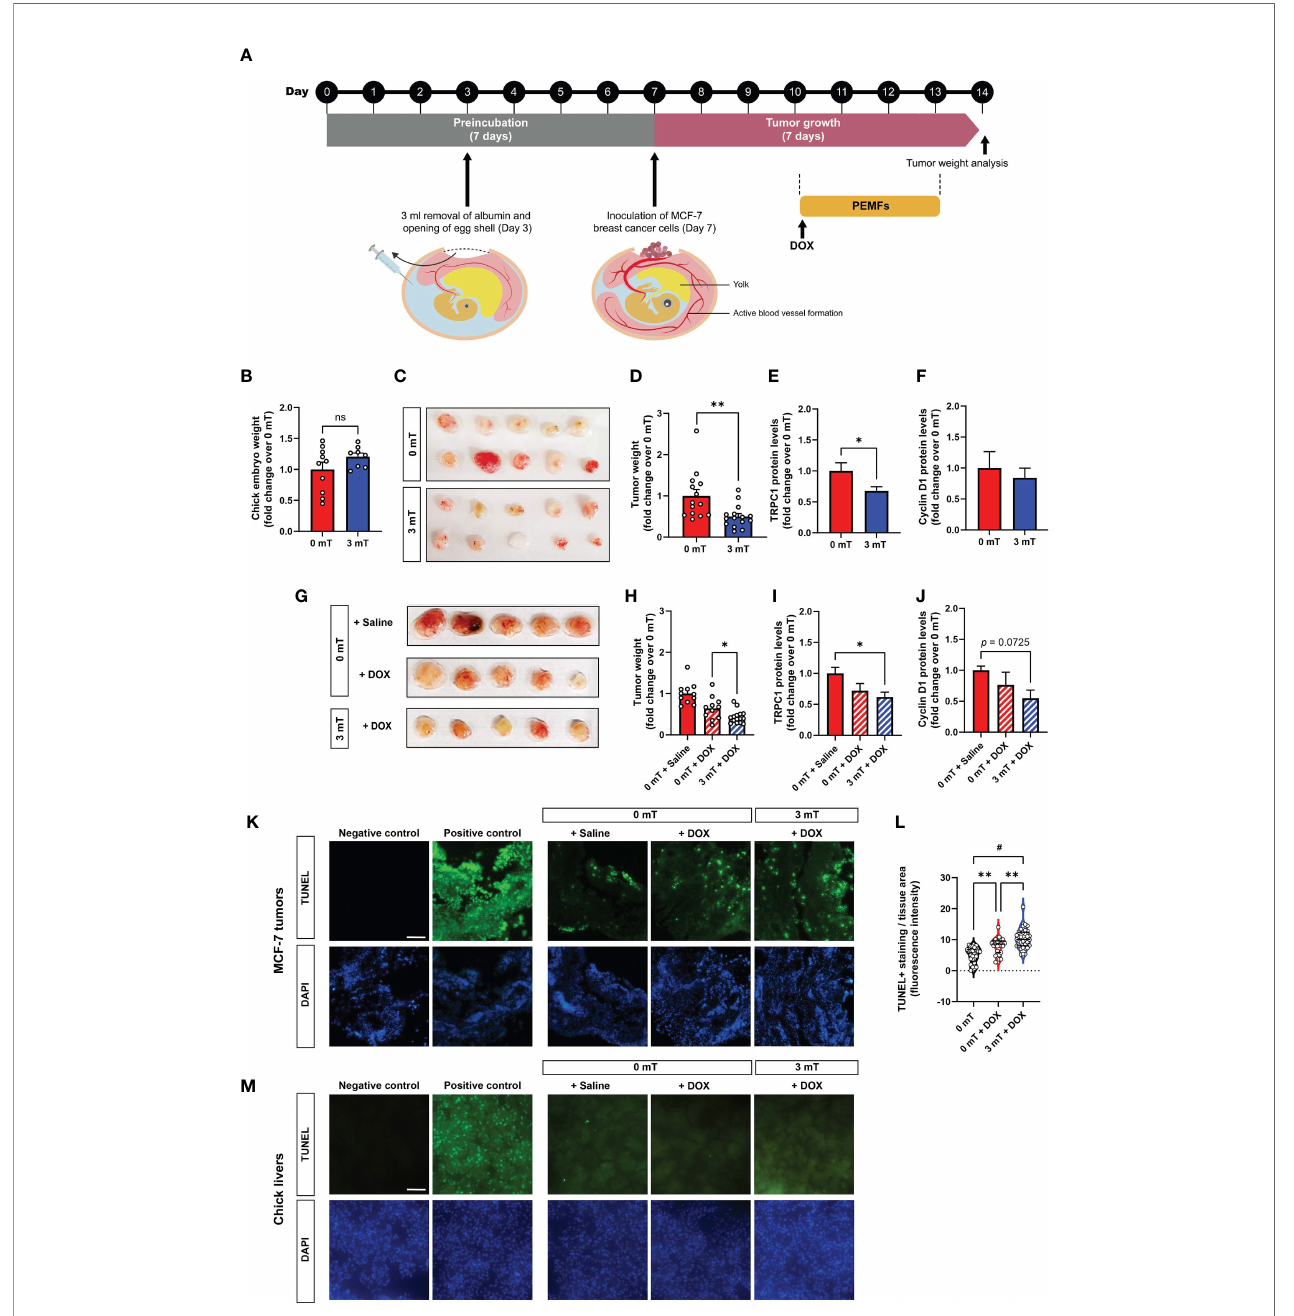
FIGURE 2 | PEMF inhibits breast tumor growth in vivo correlated with depressed TRPC1 expression levels. (A) Schematic of the PEMF exposure paradigm used on the CAM model for MCF-7 breast tumor xenografts. MCF-7 tumors were inoculated onto the CAM on day 7. The tumors were either exposed to 3 mT for 1 h for 4 successive days or exposed to 3 mT after 1 h of DOX treatment (0.04 ug/g) from day 10 onwards. (B) Chick embryo weight at study termination on day 14 for both groups. (C) Representative images of MCF-7 tumor size at day 14 and corresponding quanti fi cation (D) represented as fold change over 0 mT. TRPC1 (E) and Cyclin D1 (F) expression levels normalized to GAPDH, respectively, expressed as fold change over 0 mT. (G) Representative images showing MCF-7 tumor size after treatment with the indicated conditions. Pooled data of tumor weight (H) expressed as fold change over 0 mT. TRPC1 (I) and Cyclin D1 (J) protein expression levels normalized to GAPDH and expressed as fold change over 0 mT. Measurements were minimally in triplicates, from minimally 6 independent eggs; * p < 0.05 and **p < 0.01 or as indicated. Error bars represent the standard error of the mean. (K) Representative TUNEL staining of isolated MCF-7 CAM tumors (n=4 per group) and corresponding violin-plots (L) of TUNEL fl uorescence intensity. Two sections per tumor were analyzed using One-Way ANOVA and Sidak ’ s multiple comparisons test; ** p < 0.01 and # p < 0.0001. (M) Representative micrographs of 5 chick livers per group showing TUNEL staining under the indicated conditions. Scale bar = 100 µm. TUNEL positive controls of MCF-7 tumor and liver sections were treated with DNAse prior to the staining with TUNEL. The nuclei were stained with DAPI (blue). “ ns ” indicates statistically nonsigni fi cant